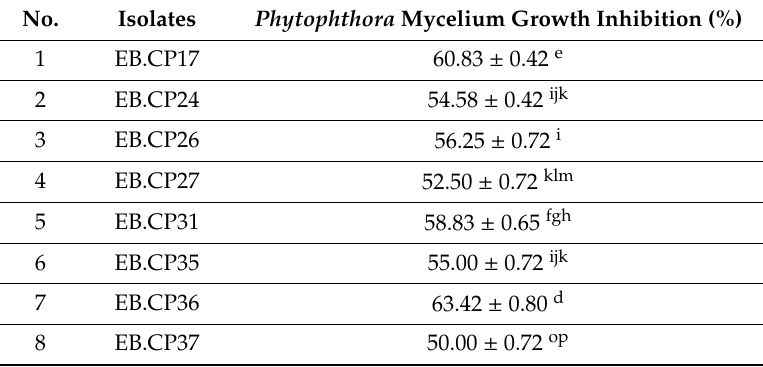
Table 1. Phytophthora antagonism activity of endophytic